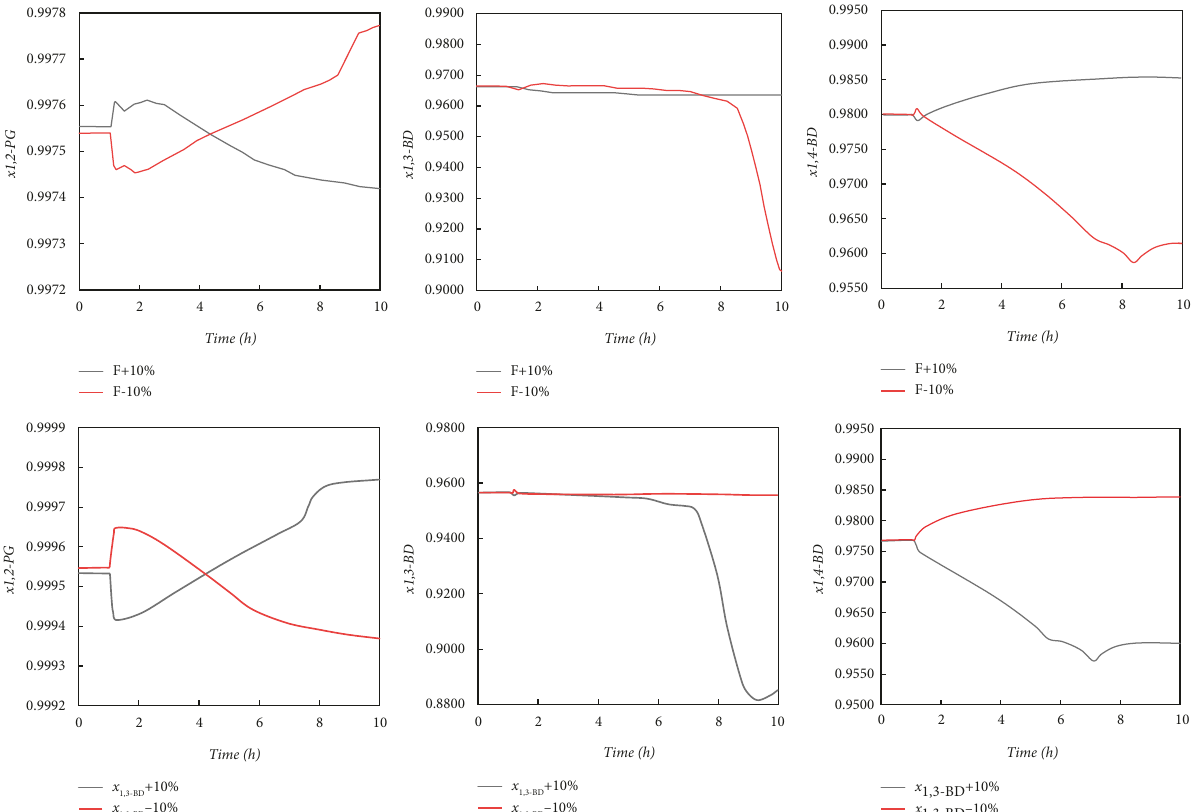
Figure 4: Dynamic responses of CS1 to ± 10% feed disturbances.